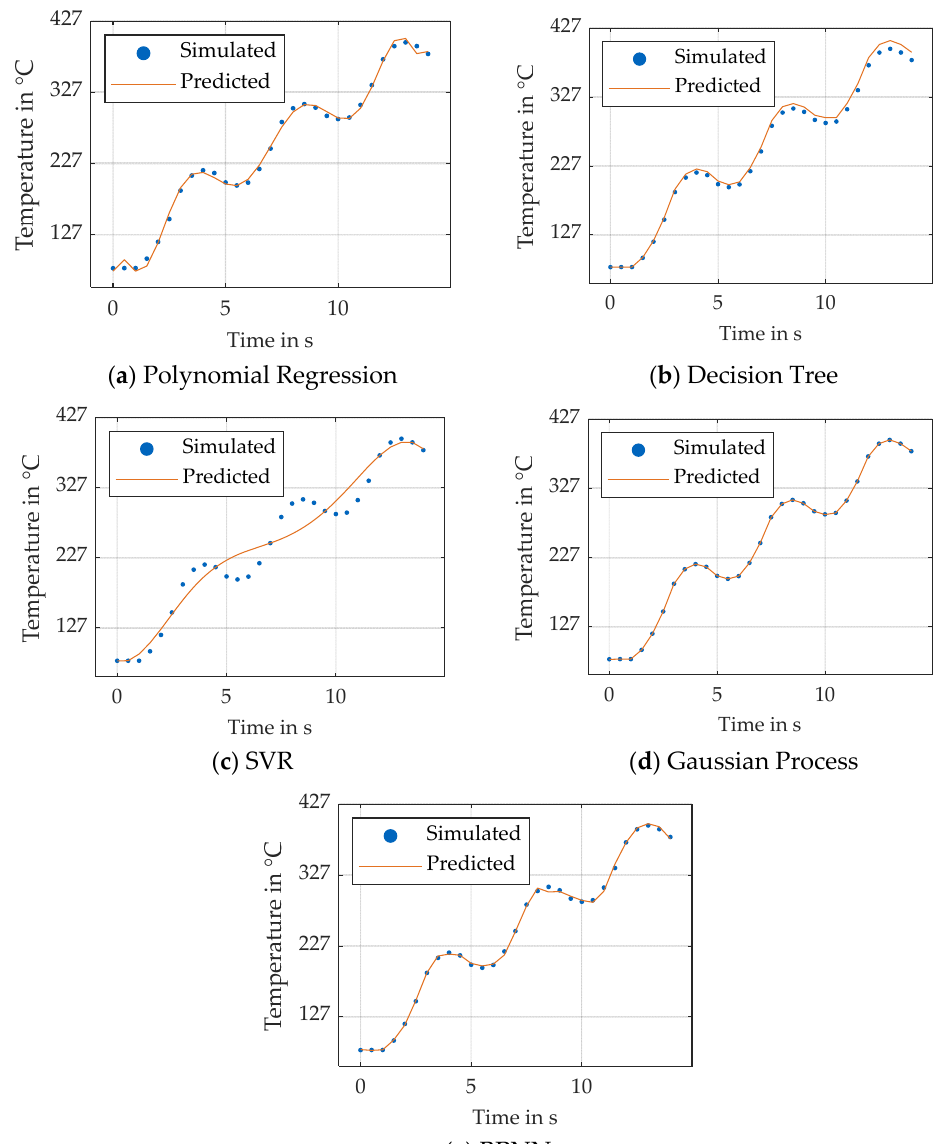
Figure 9. Exemplary predictions by the individual models for a slip cycle for Use Case 1.